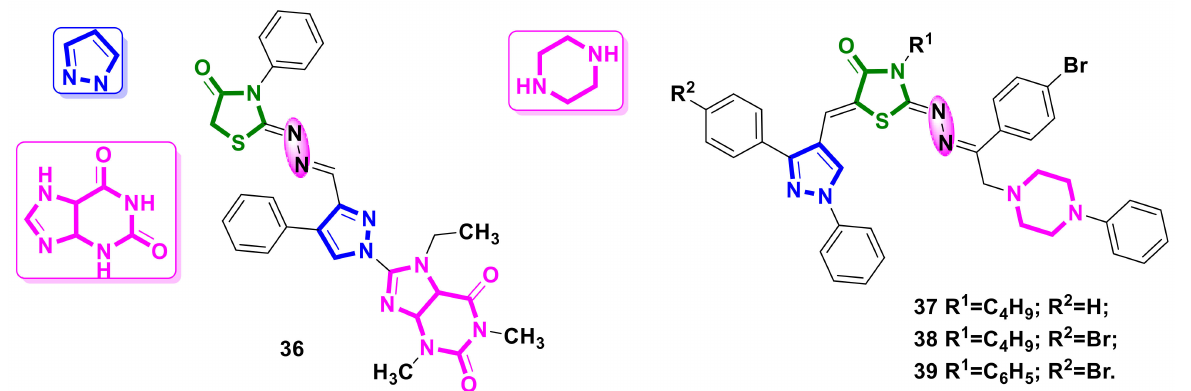
Figure 15. Pyrazole-purine- and pyrazole-piperazine–4-thiazolidinone hybrids as potential anti- cancer